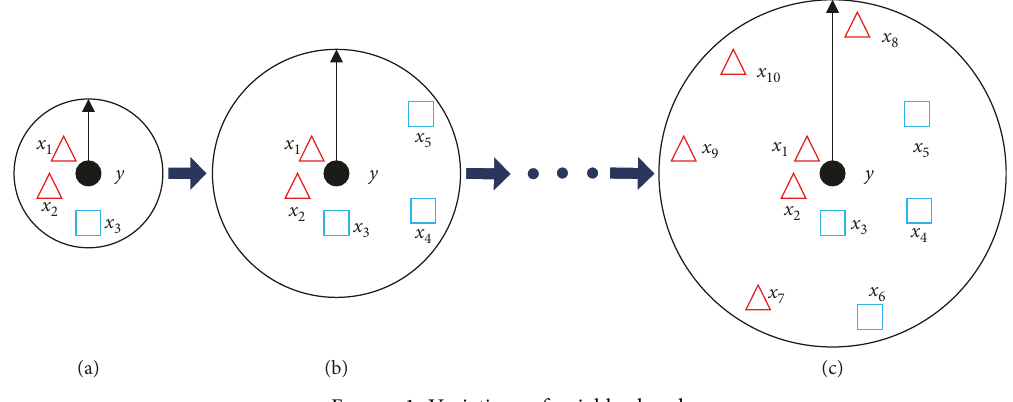
Figure 1: Variations of